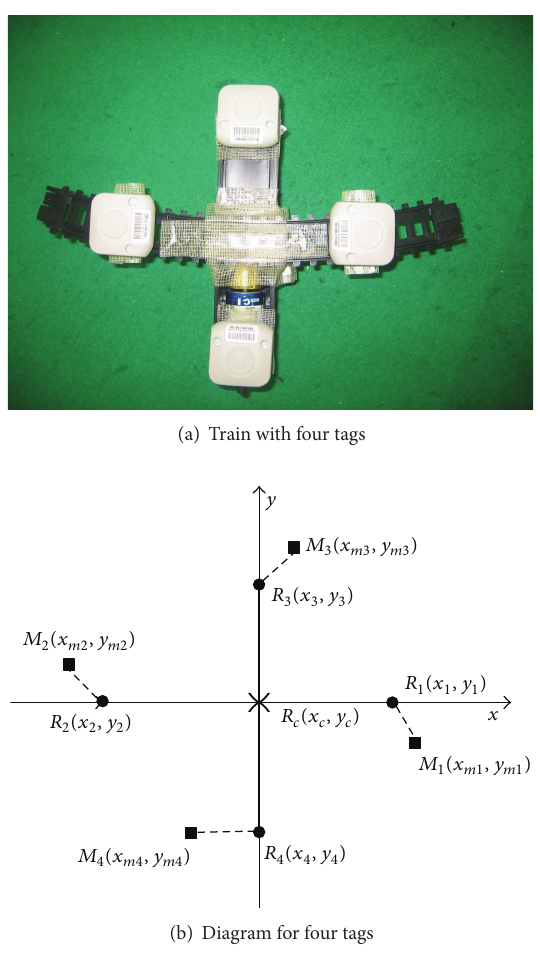
Figure 3: Train and diagram with four